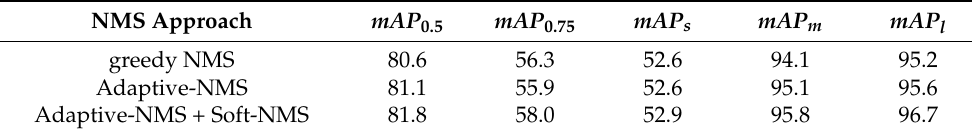
Table 5. The prediction results of different non-maximum